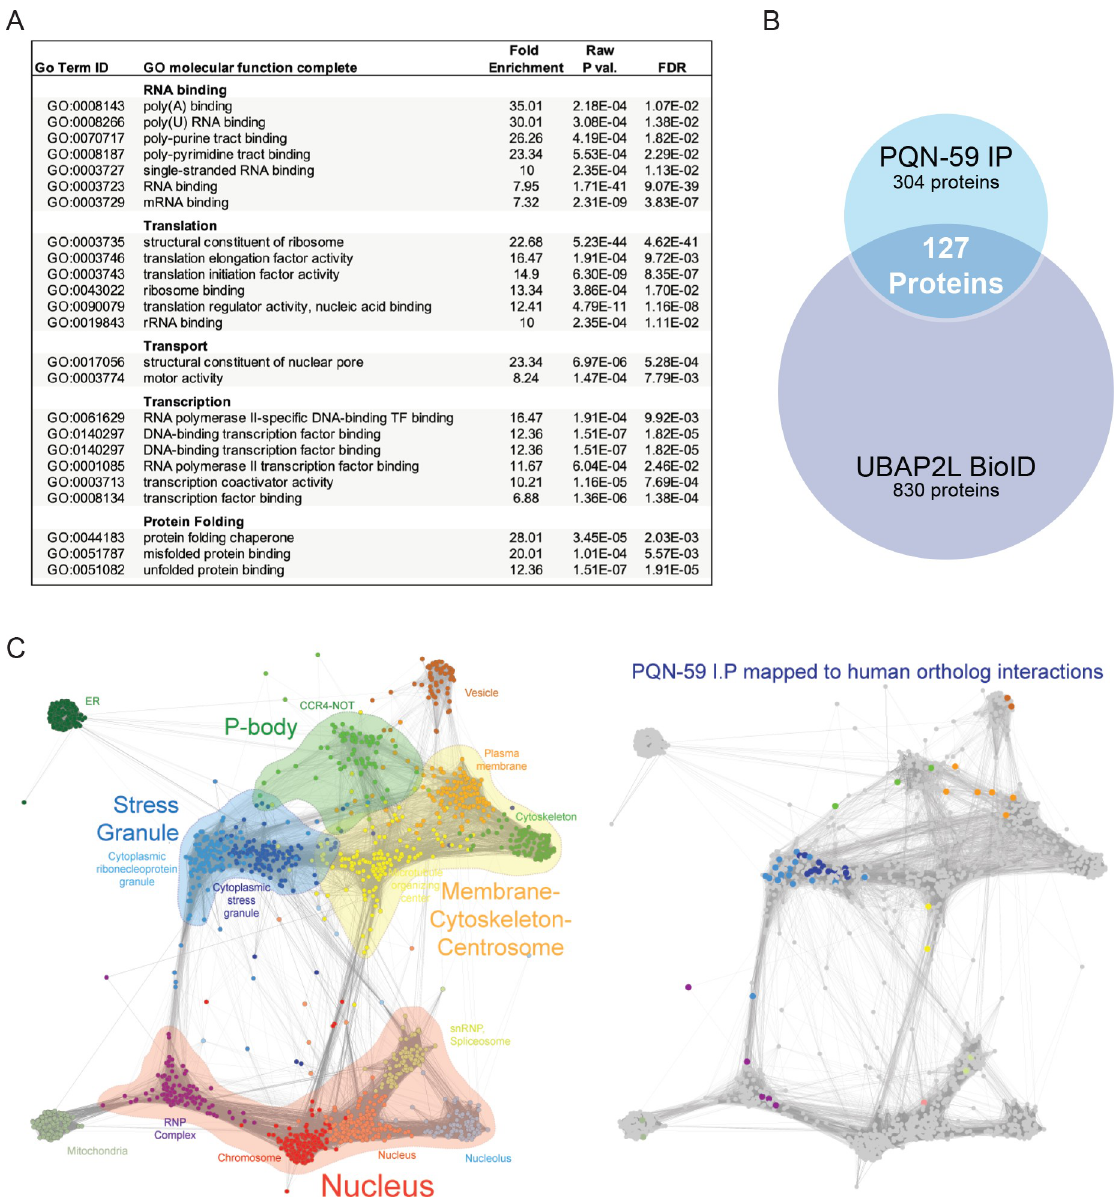
Fig 6. PQN-59 interacts with proteins involved in a variety of molecular processes and many of these interactions are shared with UBAP2L, the human ortholog of PQN-59. (A) Molecular function GO terms enrichment of PQN-59 interacting proteins isolated from developing embryos. (B) Venn diagram indicating the overlap of orthologous proteins identified in PQN-59 I.P.s and BioID experiments performed with UBAP2L in human cells outlined in Youn et al. [24]. (C) The non-negative matrix factorization (NMF) network of protein complexes identified through massively-parallel BioID assays of RNA binding proteins derived from Youn et al. (left) [24]. Each group is organized by representative GO cellular compartment term as previously described [24]. The right network illustrates the location of PQN- 59-interacting proteins that have orthologs that map to the indicated